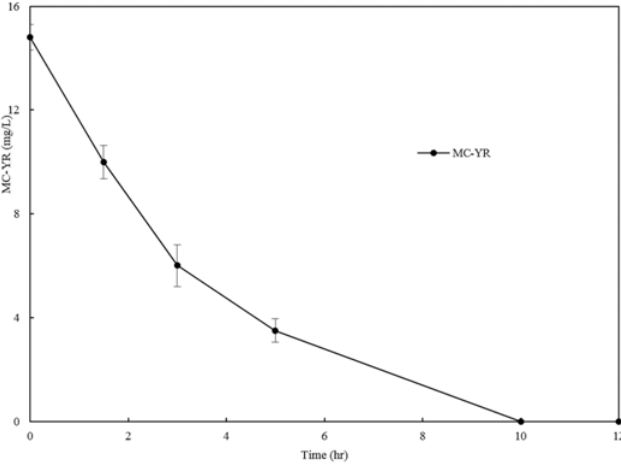
Fig 1. Biodegradation kinetics of MC-YR catalyzed by CEs of